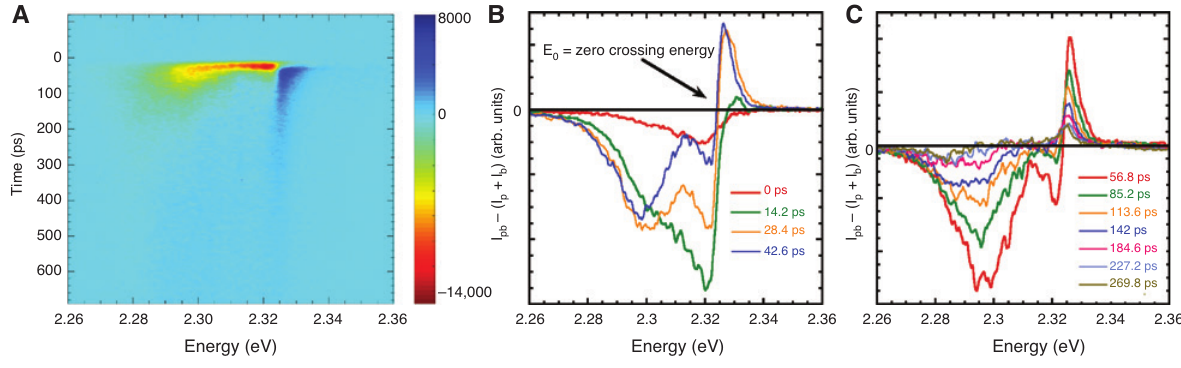
Figure 6: Bulk sample. (A) Image reporting the time evolution of the nonlinear signal I extracted from